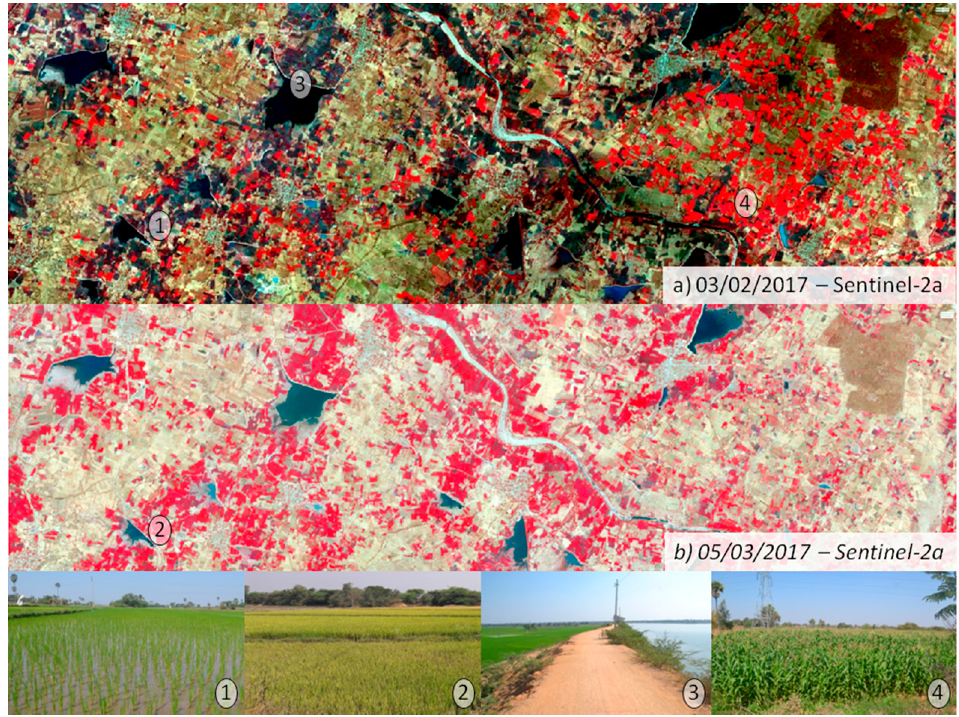
Figure 5. Crop identification using optical Sentinel-2 time series. An image in infrared-red-green display settings acquired in February 2017; ( a ) shows the mature growth stage of irrigated maize fields in red, and the early growth stage of flooded rice in brown. In March the developed rice is seen as red areas ( b ). Areas of surface water, in black, slowly decrease over time.